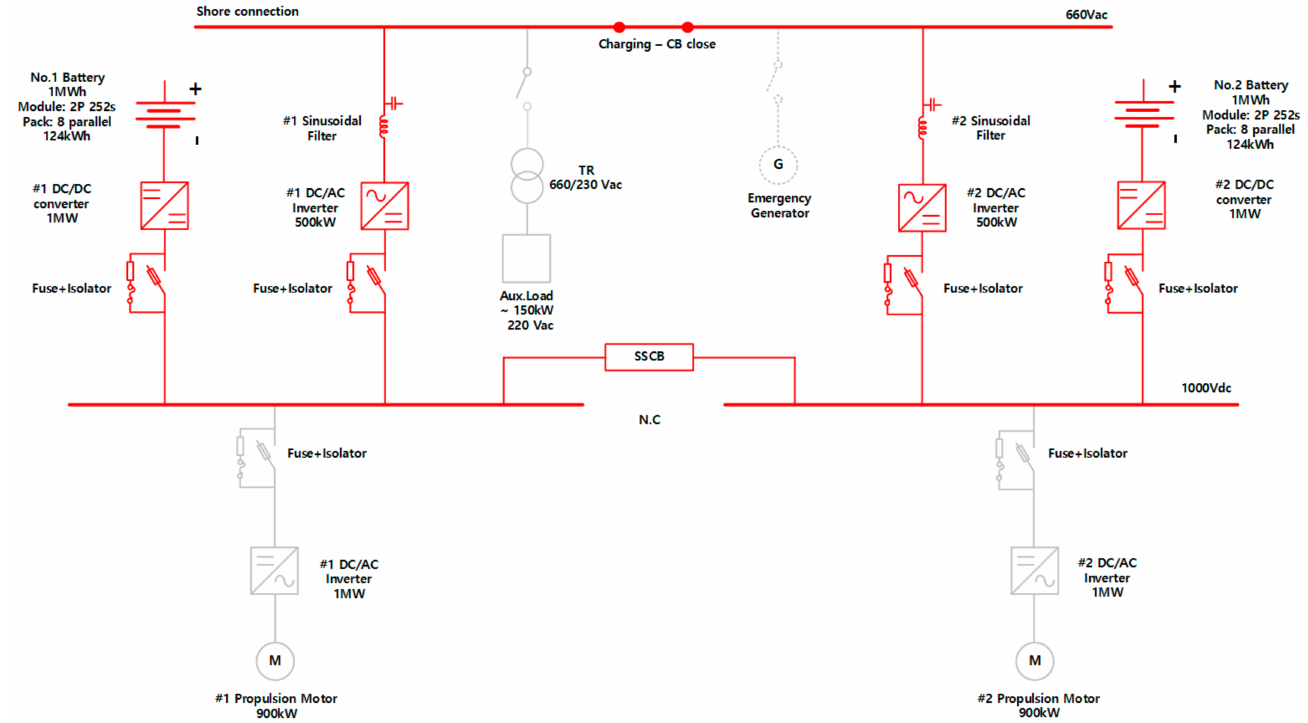
Figure 10. Schematic diagram of battery charging sequence—shore operational